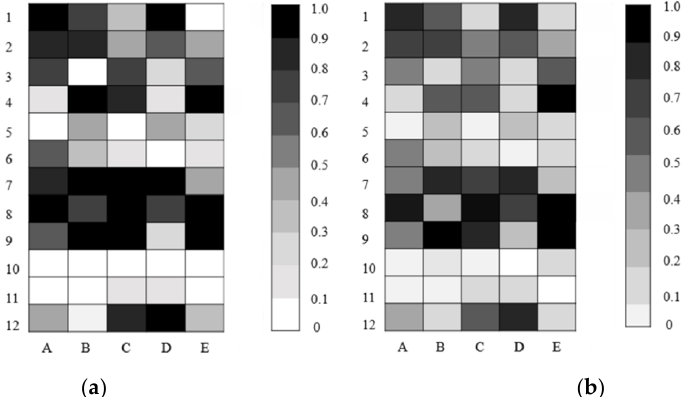
Figure 5. The abnormal probability distribution of the indicators. ( a ) Before the introduction of cross-correlation information; ( b ) after the introduction of cross-correlation information.